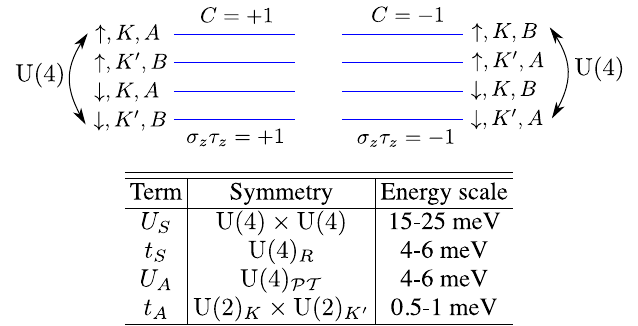
FIG. 5. Illustration of the U ð 4 Þ × U ð 4 Þ symmetry associated with the symmetric part of the interaction H . The symmetry S corresponds to arbitrary rotations among bands with the same Chern number (top panel). A table illustrating the hierarchy of energy scales and the different symmetries associated with each scale is shown in the bottom panel. Here, U ð 4 Þ η denote the U(4) subgroup of unitary matrices in U ð 4 Þ × U ð 4 Þ commuting with η